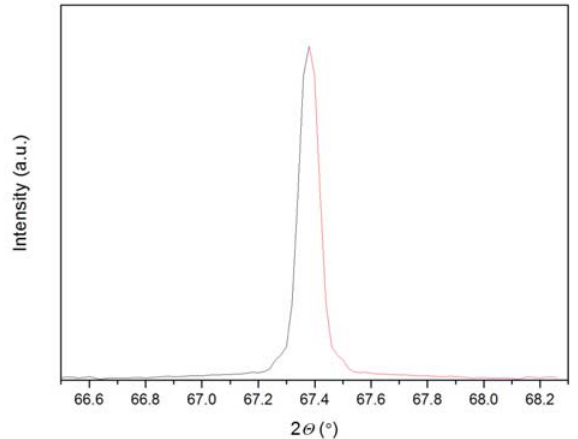
Figure 10. The result of the analysis for the left-hand profile.